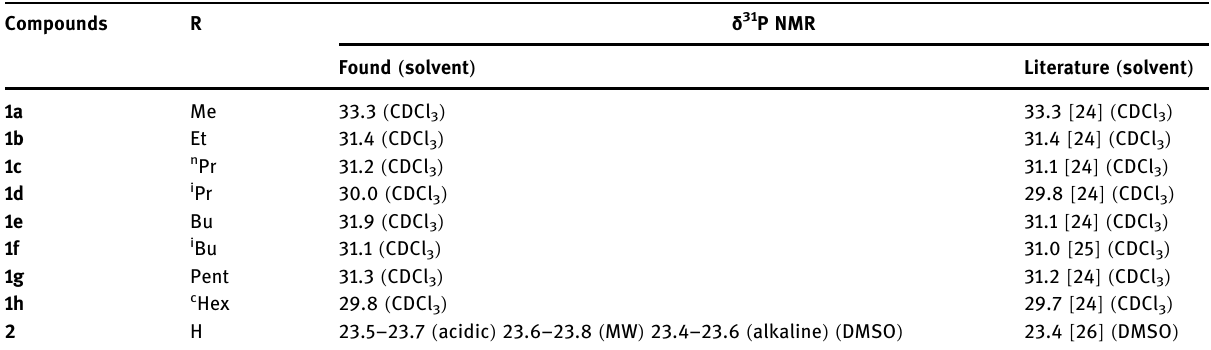
Table 1: 31 P NMR characterization of diphenylphosphinates ( 1a – h ) and diphenylphosphinic acid ( 2 )